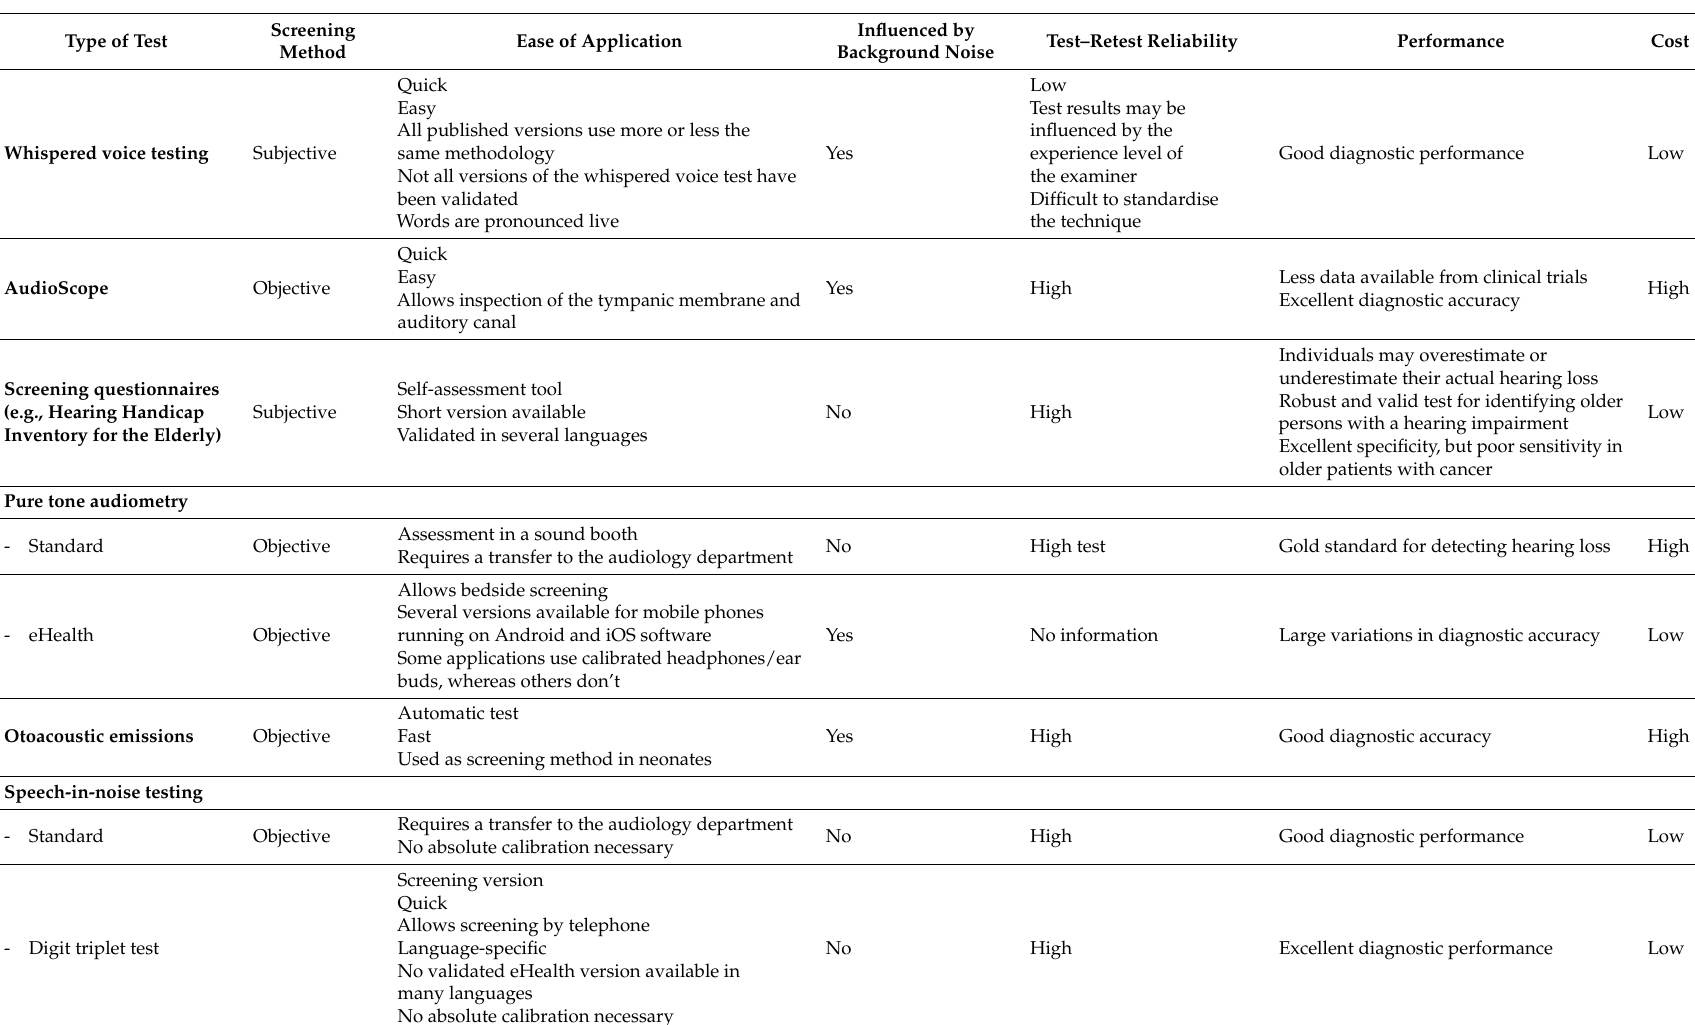
Table 1. Advantages and disadvantages of the selected screening methods to assess hearing loss in older patients with